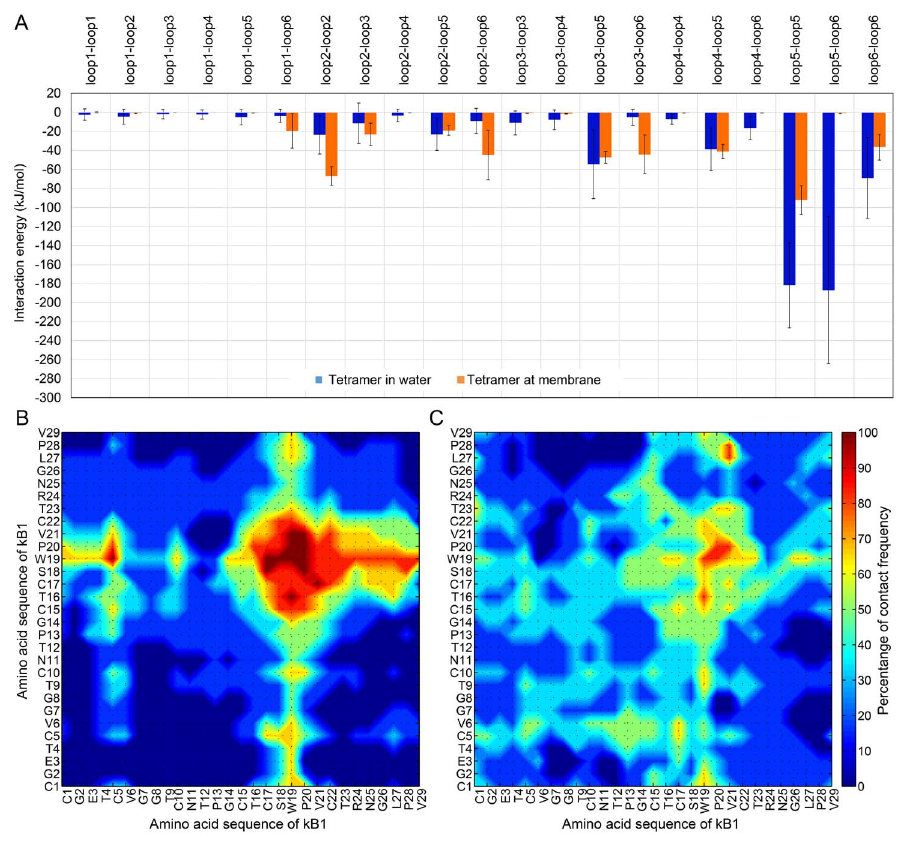
Figure 2. Pattern of kB1-kB1 interaction. (A) The intermolecular loop-to-loop interaction energies of the tetramer in water (blue bar) and in its membrane-bound state (orange bar) are shown. The interaction energies were averaged across 22.3–5.0 m s. The error bar represents the standard deviation of the average values. Matrices representing the contact frequencies for the tetramer in (B) water and (C) in its membrane- bound state are shown. The contact frequency for each AA residue pair of the tetramer in water and in its membrane-bound state were measured from 0–2.6 and 22.4–5.0 m s,